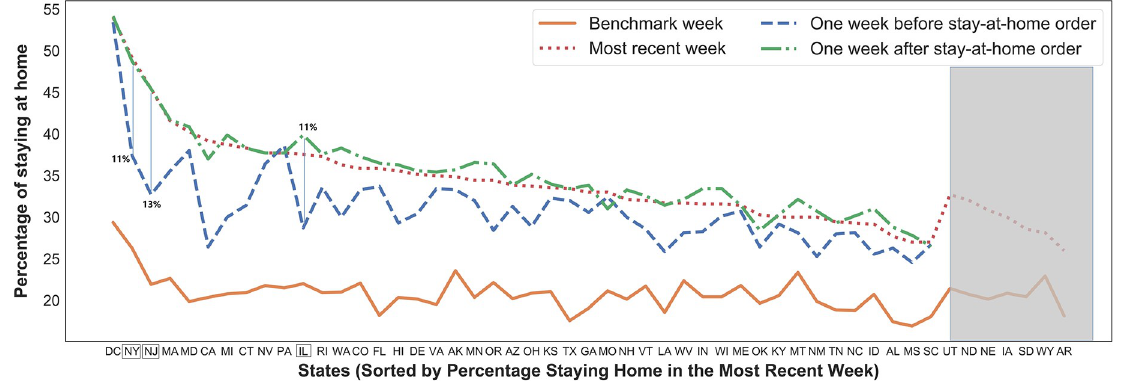
Fig 3. Statewide trends on the percentage of people staying